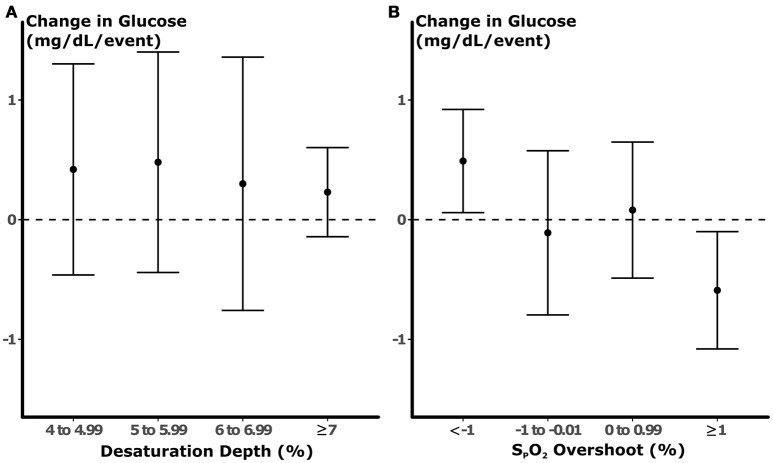
Results of univariable models of glucose. Each point represents the change in glucose (±95% confidence interval) predicted by the number of desaturation (A) or overshoot (B) during the preceding 10 min prior to blood sampling. No statistically significant association was observed between desaturation depth and glucose. In contrast, each apneic episode that was followed by partial normalization of oxygenation was associated with an increase in glucose by 0.49 mg/dL. With increasing degrees of SPO2 overshoot, the changes in glucose related to each event fell, and SPO2 peaks that exceeded baseline by >1% were associated with reductions in glucose.